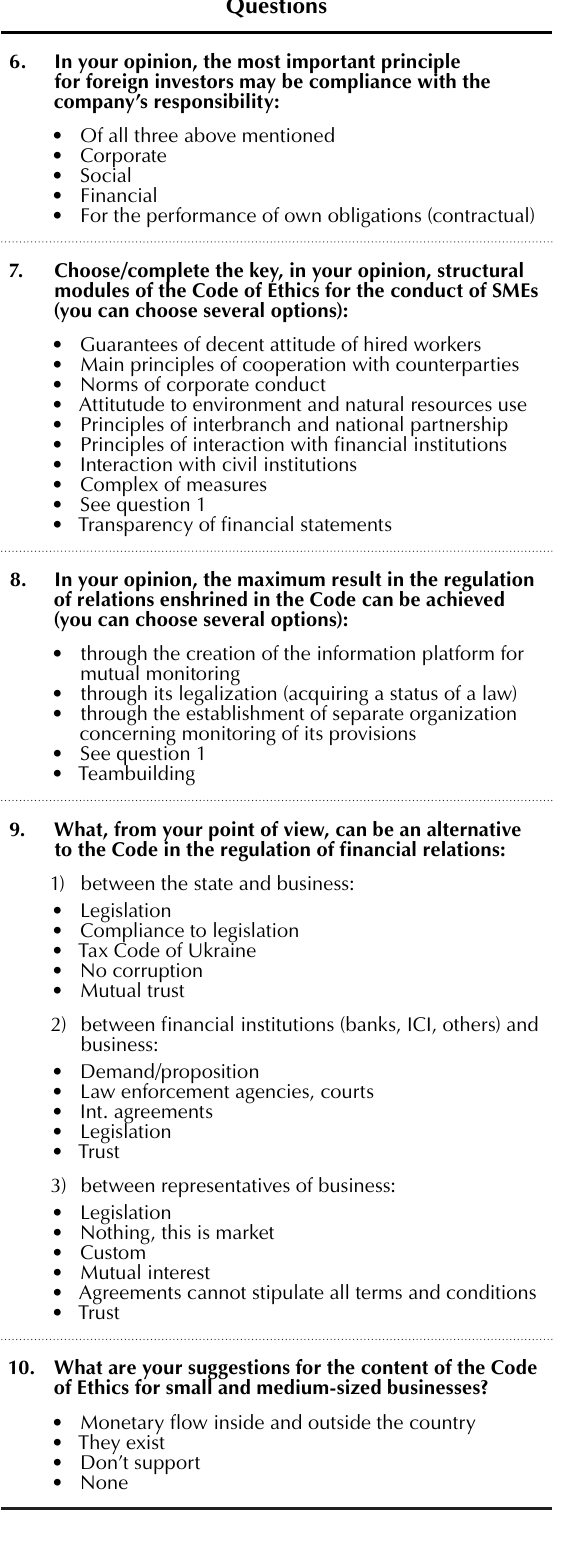
Table 1 (cont.). The list of questions of marketing research on the theme “Necessity of the Code of Ethics implementation for the Management of Small and Medium-Sized